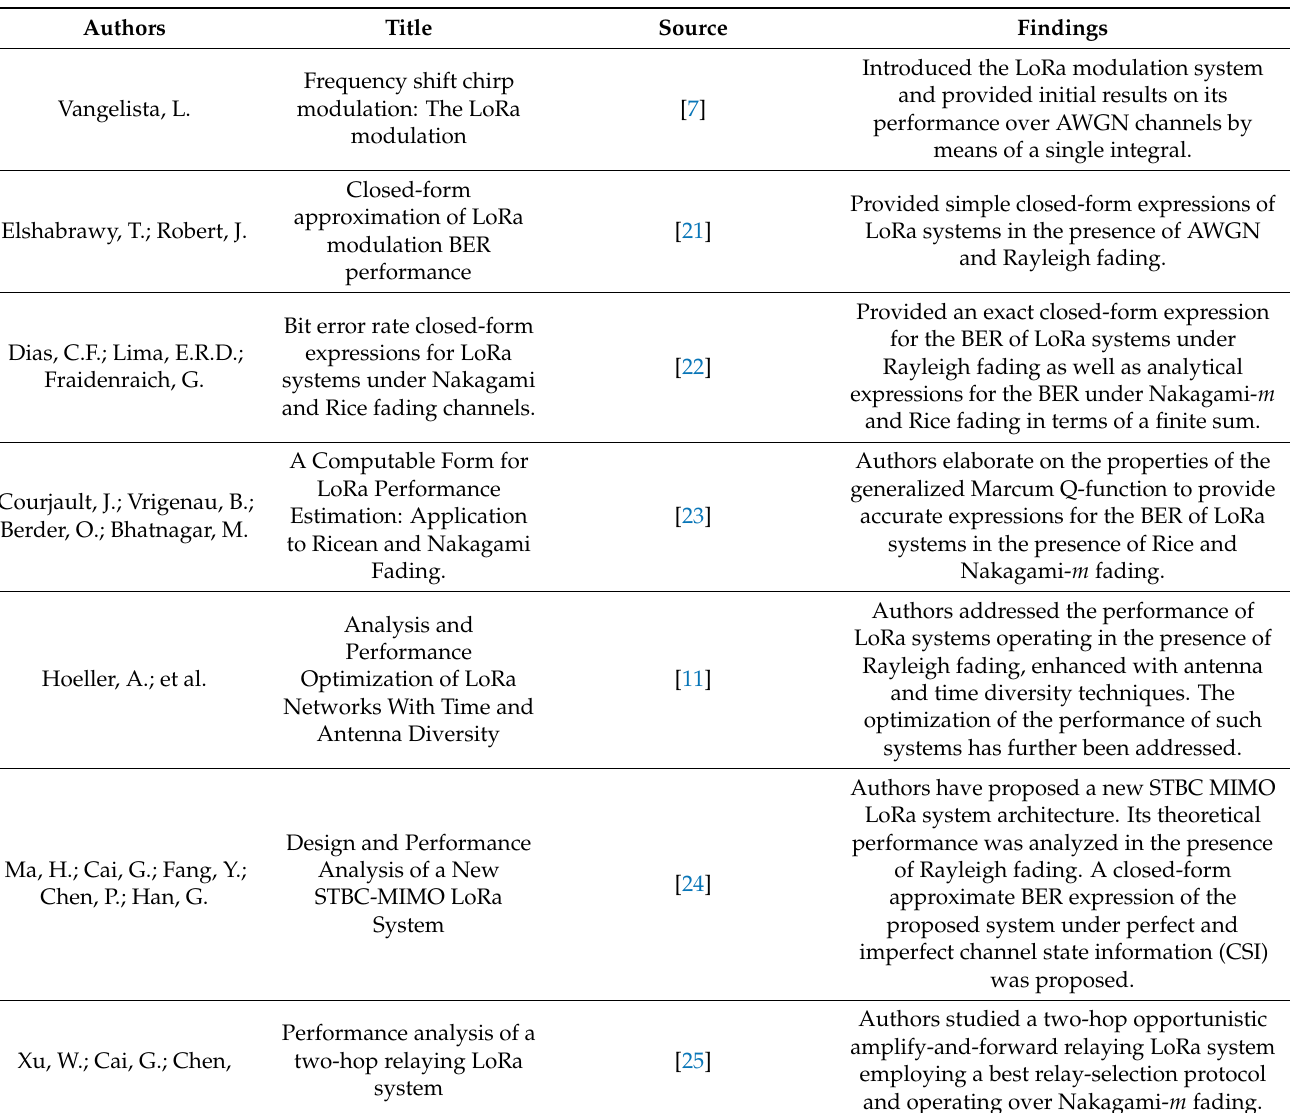
Table 1. Related works on theoretical performance of LoRa systems in the presence of fading and